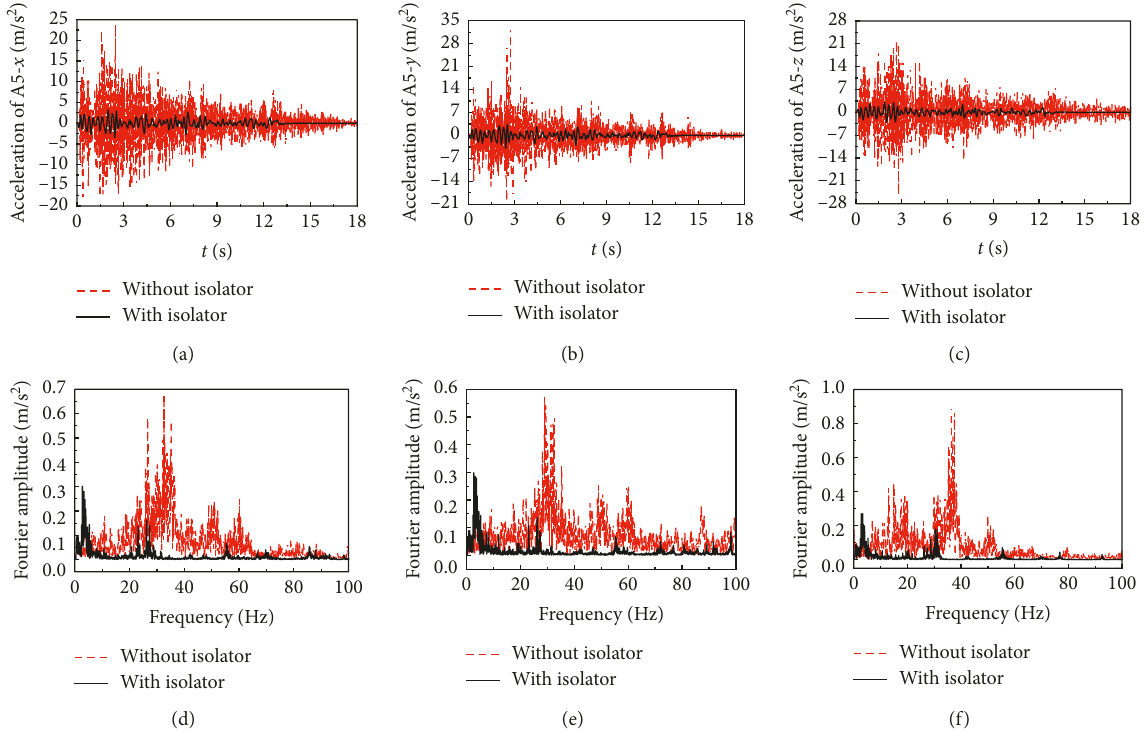
Figure 8: Response of acceleration time history and its corresponding Fourier curve of A5 at top node. (a) Response of acceleration of A5- x ; (b) responseof acceleration of A5- y ; (c) response ofacceleration of A5- z ; (d) Fourier curve of A5- x ; (e) Fourier curve of A5- y ; (f) Fourier curve of A5- z